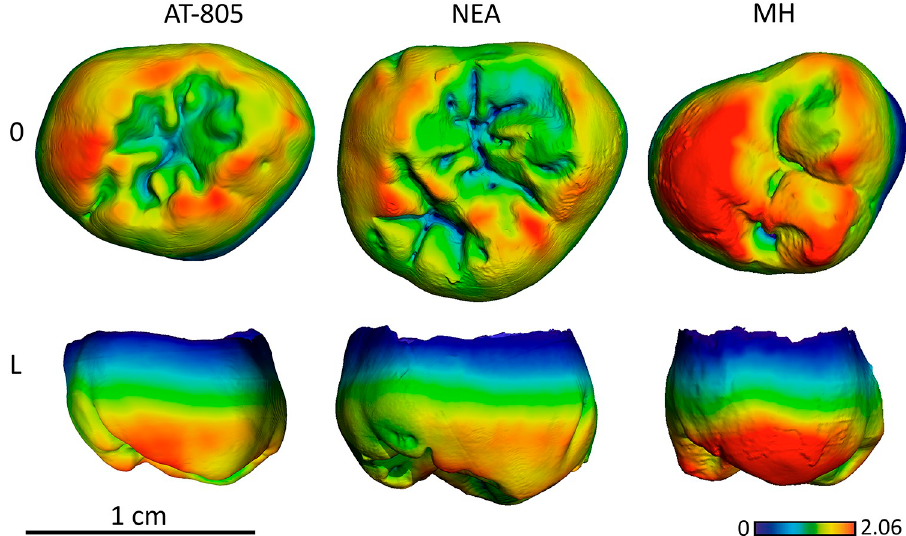
Fig 11. Enamel thickness cartographies of the Atapuerca-SH upper M3 (AT-805) compared with those of Neanderthal and modern human. Topographic thickness variation is rendered by a pseudo-color scale ranging from thinner dark-blue to thicker red. NEA = Neanderthal (Krapina, D99) and MH = modern human of European origin (O = occlusal, L = lingual). (When needed specimens have been mirrored to the left to match the SH specimen).